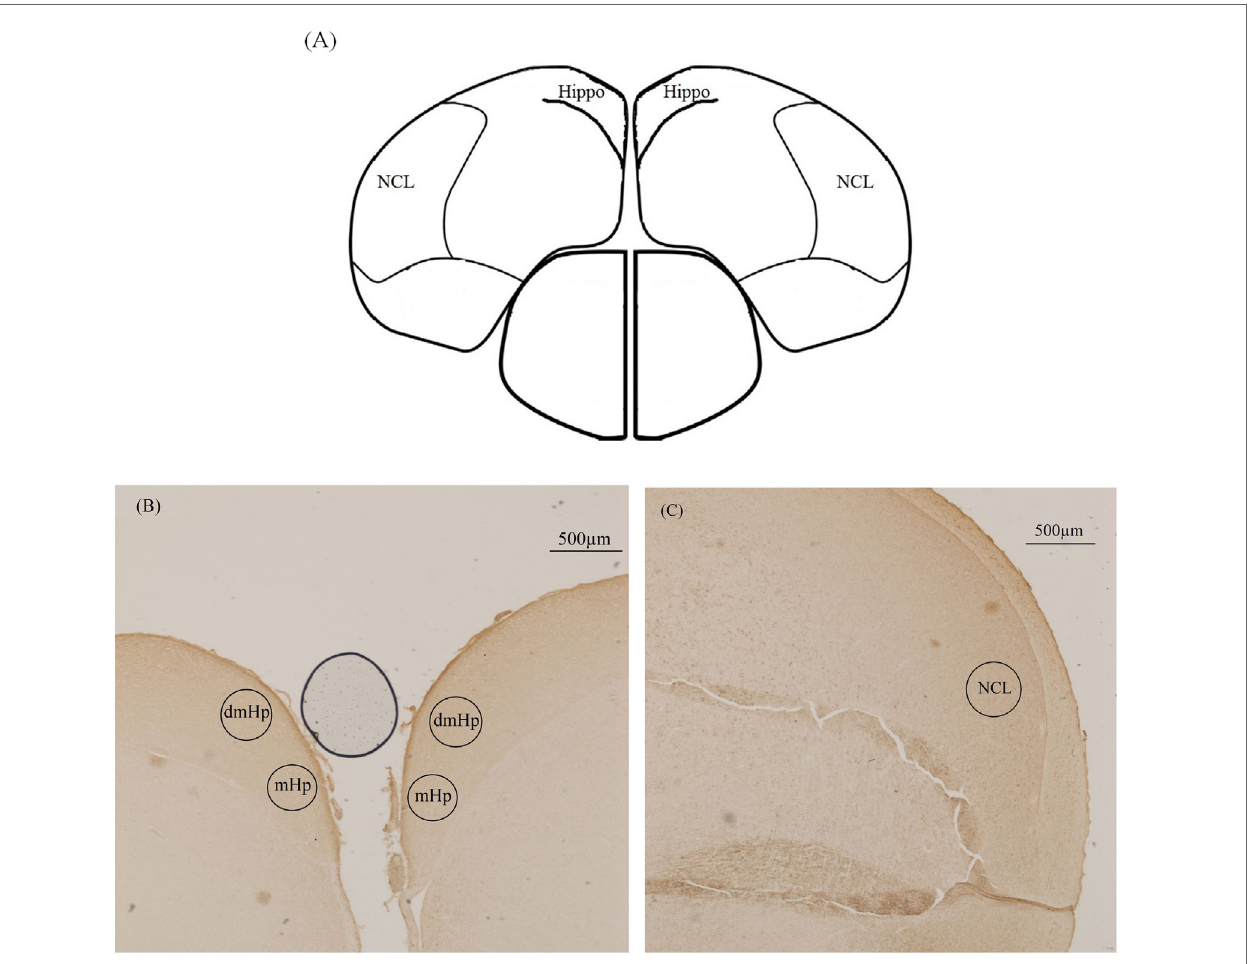
FigUre 1 | illustration of the location of the three analyzed brain areas in the immunohistochemical staining of tyrosine hydroxylase . (a) Schematic drawing of the chicken brain sectioned along the coronal plane illustrating the hippocampus (Hippo) and caudolateral nidopallium (NCL) (interaural 2.56 mm). (B) Photograph of dorsomedial hippocampus (dmHp) and medial hippocampus (mHp). (c) Photograph of caudolateral nidopallium